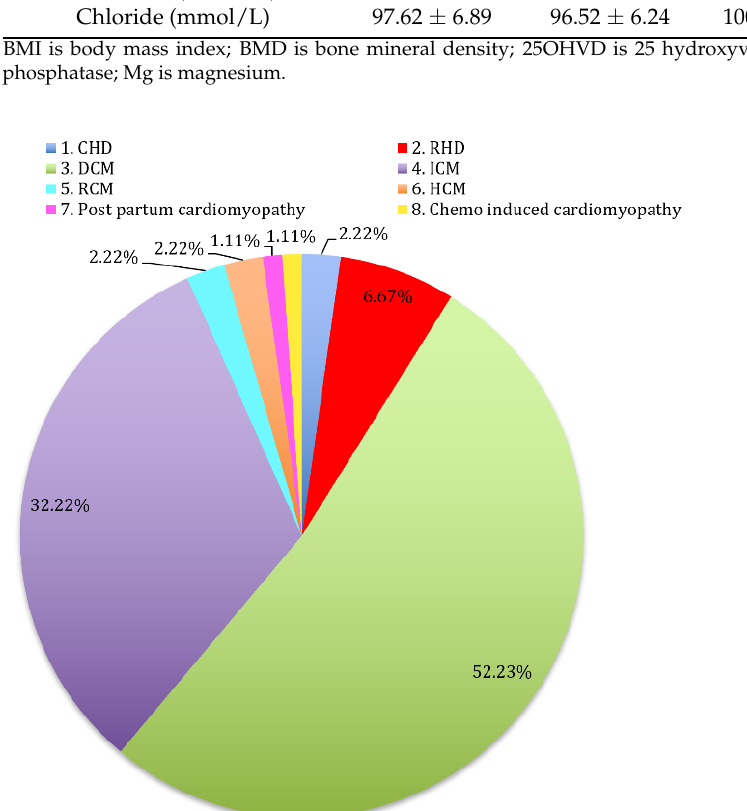
Table 1. Pretransplant characteristics of the study sample.